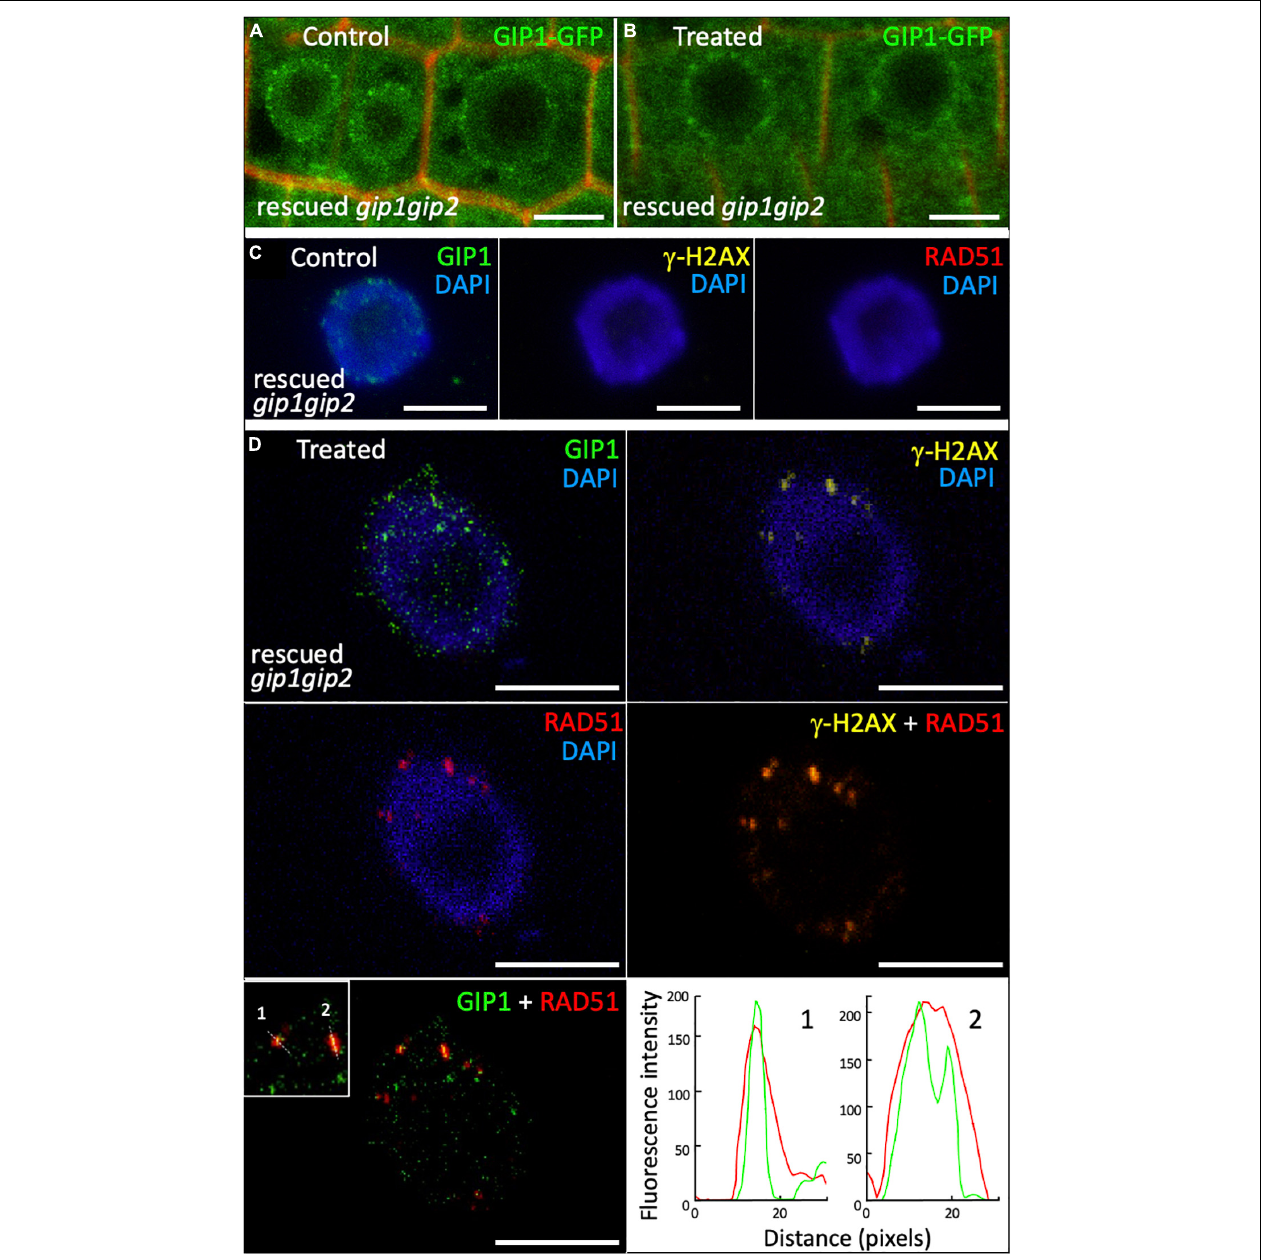
FIGURE 6 | Localization of GIP1-GFP in response to DNA damage induced by cisplatin. GIP1-GFP was expressed in the gip1gip2 mutant and rescued cellular phenotypes as described (Batzenschlager et al., 2015). Nine-day-old seedlings were treated or not (control) by 50 µ M CP during 16 h in 1 / 2 MS. (A,B) GIP1-GFP localization was analyzed in root meristematic nuclei in control (A) and treated (B) cells. Cell wall was detected by propidium iodide staining. Representative images are presented. (C,D) Immunolocalization was performed on root tip nuclei using antibodies against GFP, γ -H2AX and RAD51 and DAPI staining. Two independent experiments were performed. Representative images of GIP1-GFP, γ -H2AX, and RAD51 foci are presented for control (C) and treated (D) cells. Merge images are presented for γ -H2AX (yellow) and RAD51 (red) as well as for GIP1-GFP (green) and RAD51 (red). Fluorescence profiles illustrate the colocalization of GIP1-GFP (green) and RAD51 (red) foci along the white dotted lines indicated on the left panel. Scale bars = 5 µ